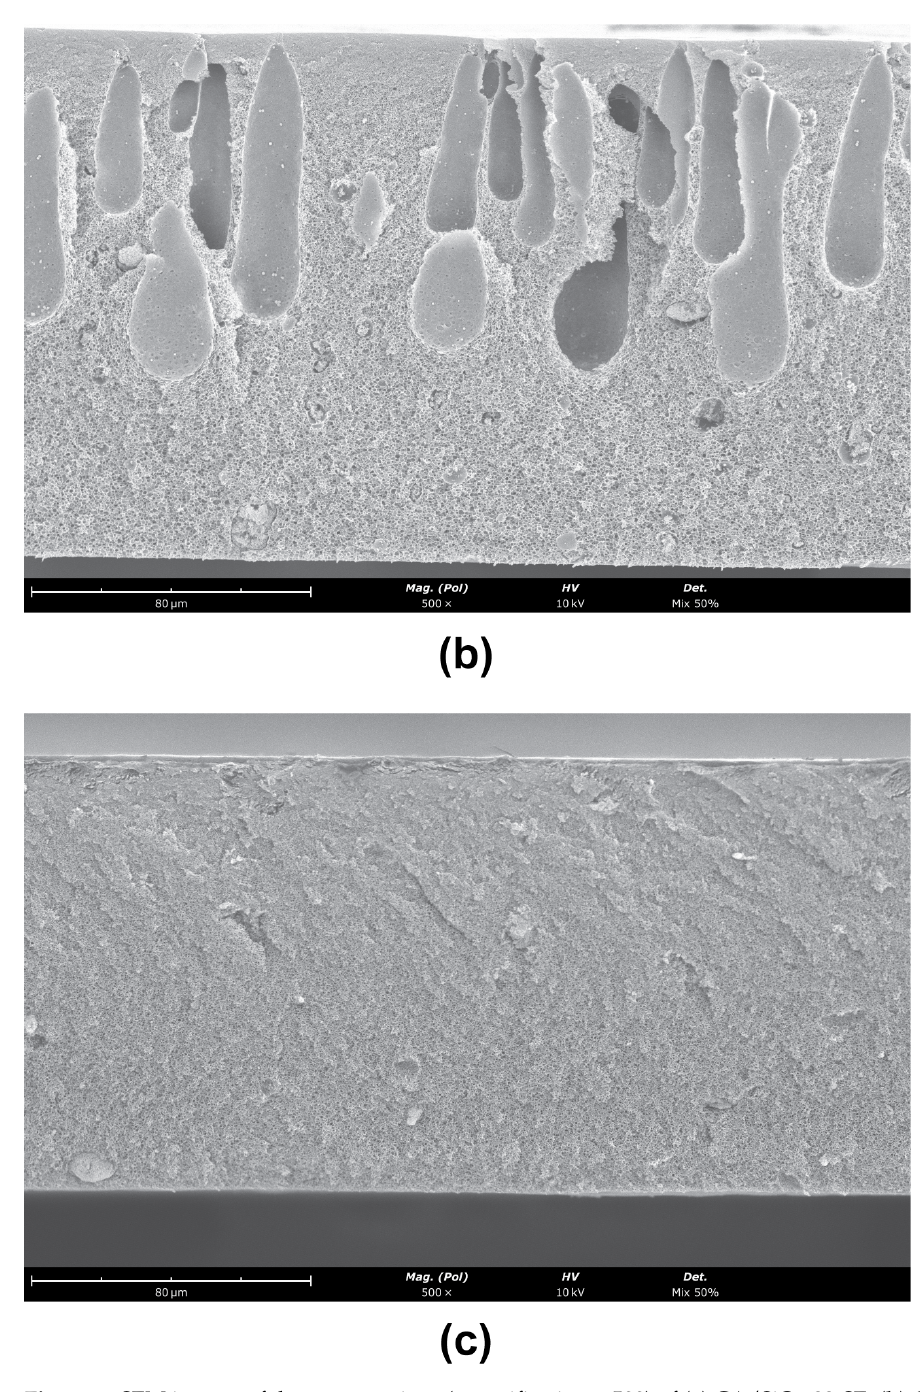
Figure 7. SEM images of the cross-sections (magnification × 500) of ( a ) CA/SiO 2 -22-SE, ( b ) CA/SiO 2 - 30-SE and ( c ) CA/SiO 2 -30-SE. The active layer is located at the top surface of the membrane. The asymmetric nature of these membranes is identified in the cross-section of the membranes, with a significant decrease in pore dimensions towards the active layer. The ac- tive layer pores are not observable. Finger-like macro-void structures detected in the CA/SiO 2 -22-SE and CA/SiO 2 -SE membranes seem to have no significant impact on the measurements carried out. Figure 8 reports the average cavity radius extracted from the SEM images near the bottom and close to the active layer at the top of the membrane, obtained with ImageJ software. The data show the decreasing trend of the pore radius towards the active membrane layer in all